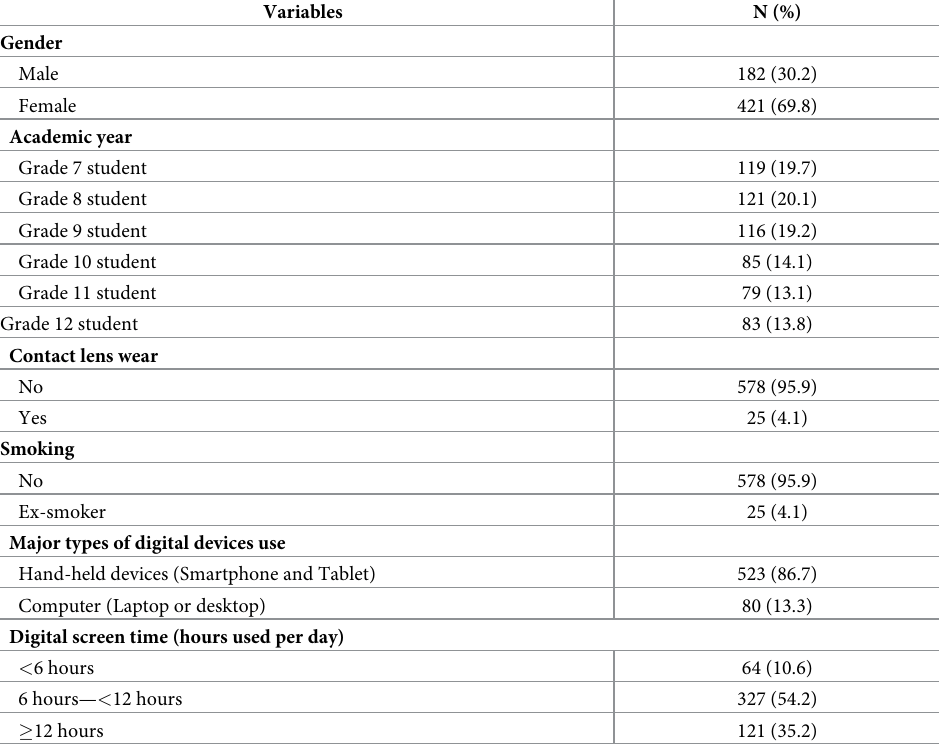
Table 1. General demographics of respondents enrolled in this study (N =